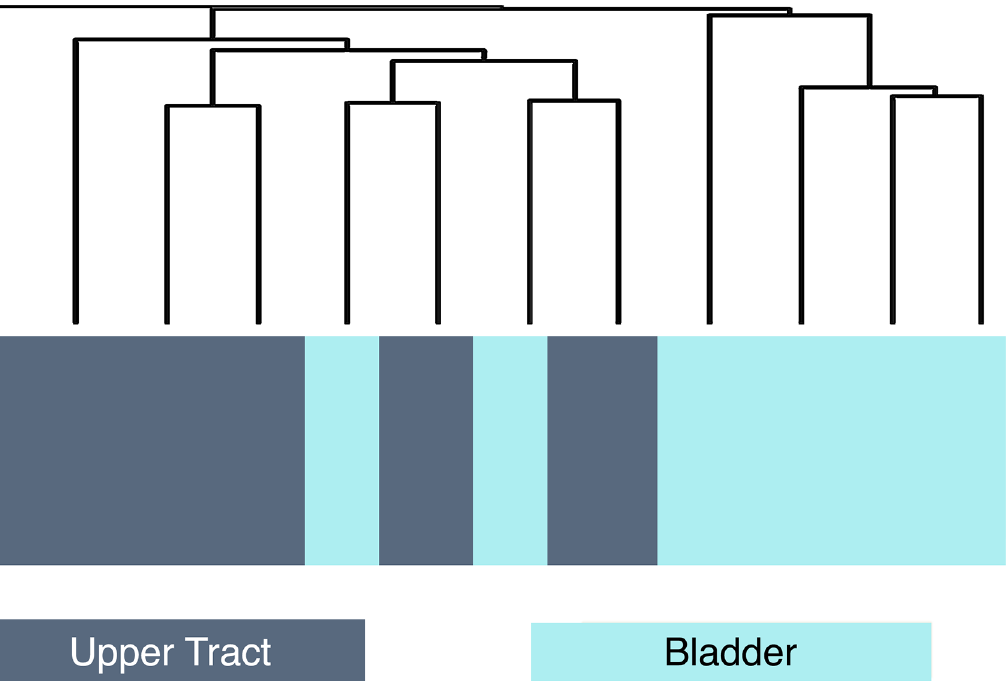
Fig 1. Hierarchical clustering of pT3 tumors shows differential clustering between upper tract and bladder urothelial carcinoma.